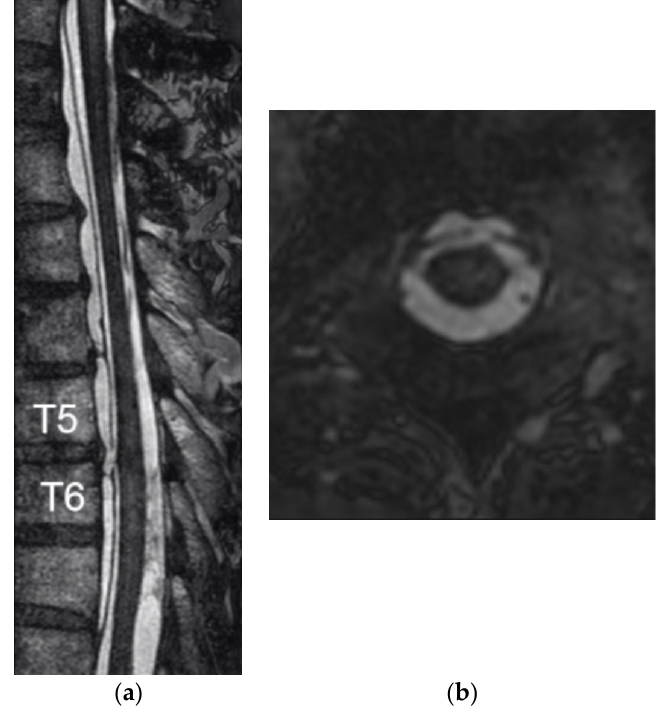
Figure 2. A balanced turbo field echo (BTFE) MRI sequence, which achieves rapid and high-resolution imaging of the spinal anatomical structures, reveals a gap in the anterior dura mater at the T5–T6 level. ( a ) sagittal-, and ( b ) axial-oriented images.